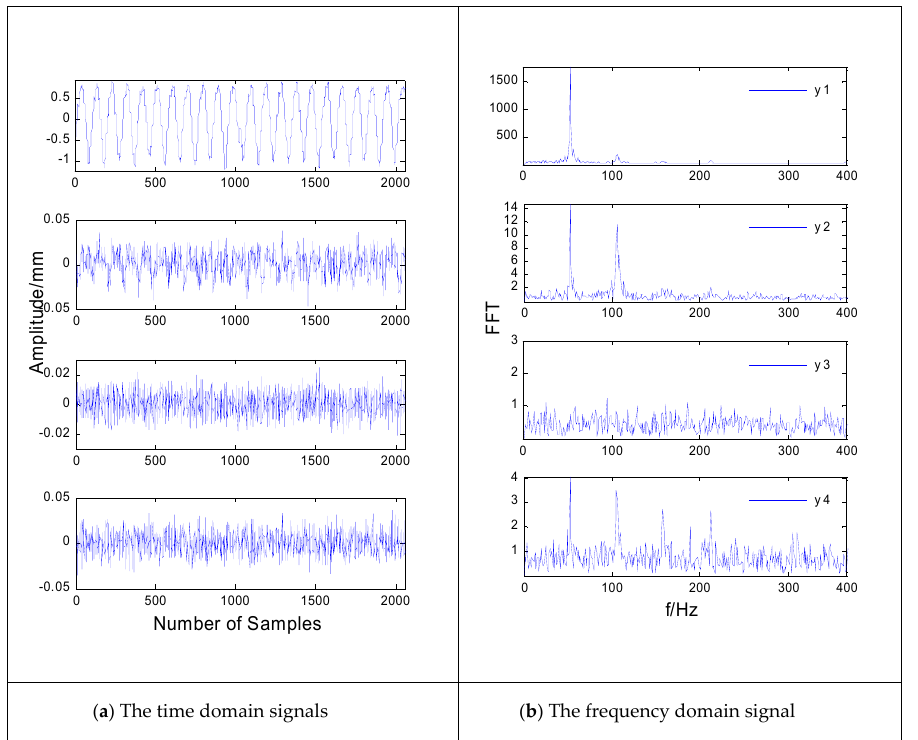
Figure 10. The signals separated by the MF-SOBI algorithm.